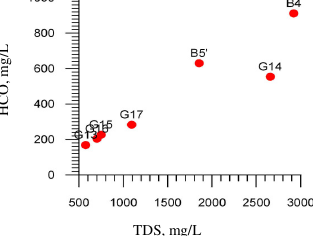
Figure 7. The relation between TDS and the restored HCO